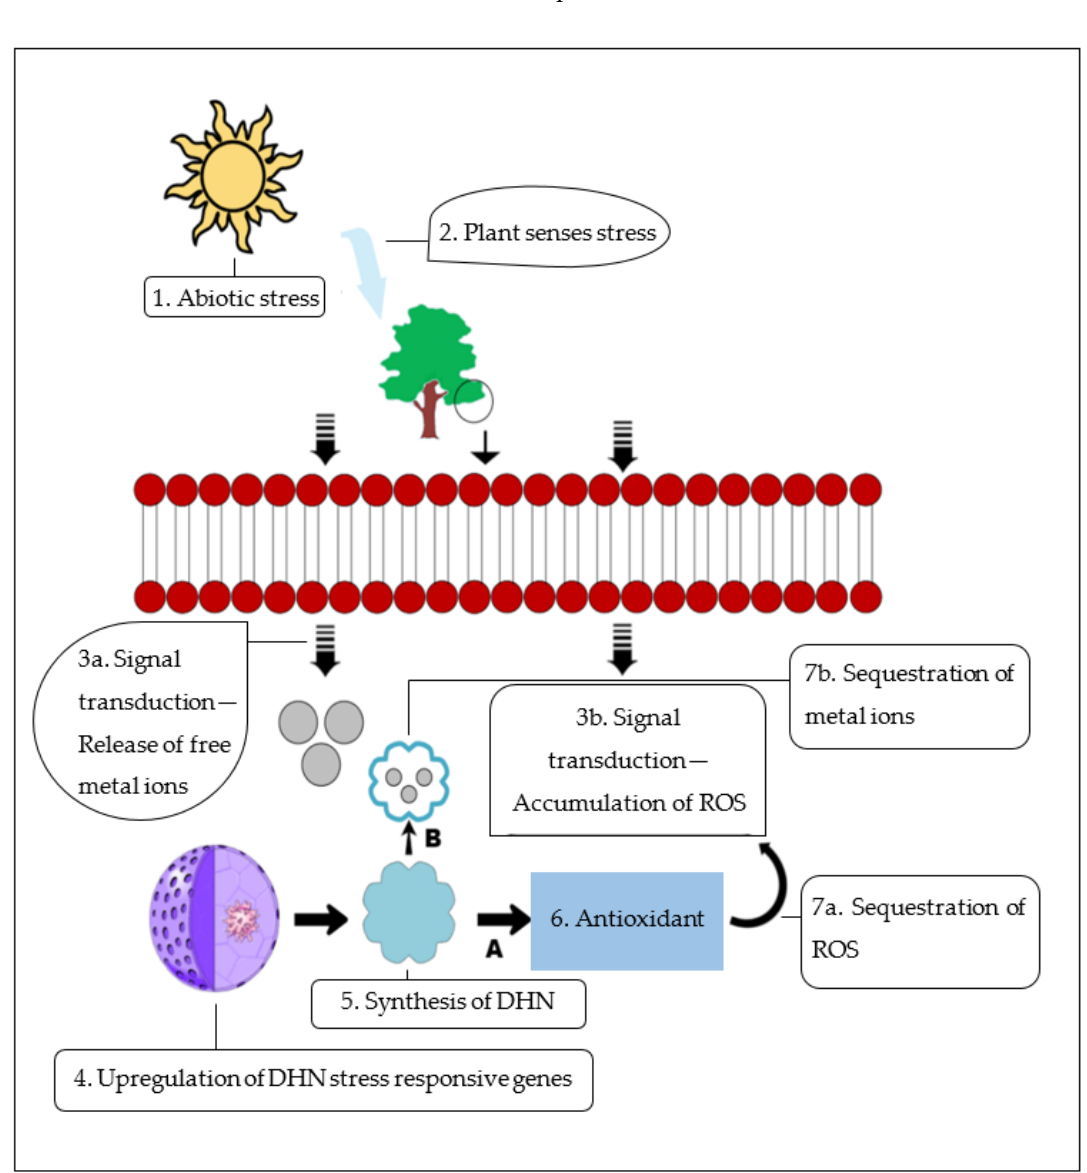
Figure 4. Functional role of DHNs under the abiotic stress ( A —ROS scavenging as antioxidant, B —Metal-ion binding). Under the abiotic stress condition, the plant senses the stress and signals its organelles for the presence of stress through the release of free metal ions or through the accumulation of ROS. After the signal transduction, DHN genes are upregu- lated within the nucleus, and DHNs are synthesized for the stress tolerance mechanism. Both phenomena ( A , B ) can occur within plant cells based on the signal transduction pathway. ( A ) DHNs act as antioxidants and scavenge ROS that accu- mulate within the plant cells. ( B ) DHNs, through their property of metal-ion binding, also scavenge the free metal-ion radicals that arise within plant cells under abiotic stress.